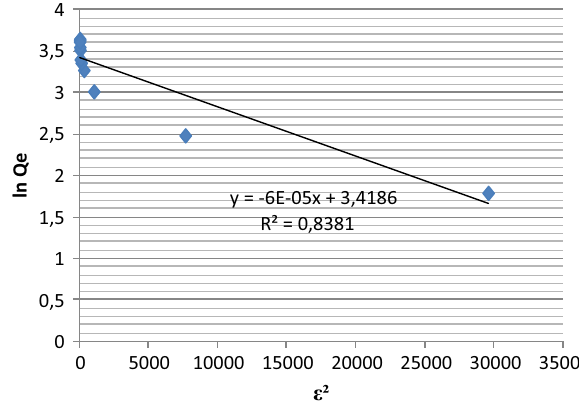
Fig. 5 Dubinin–Radushkevich adsorption